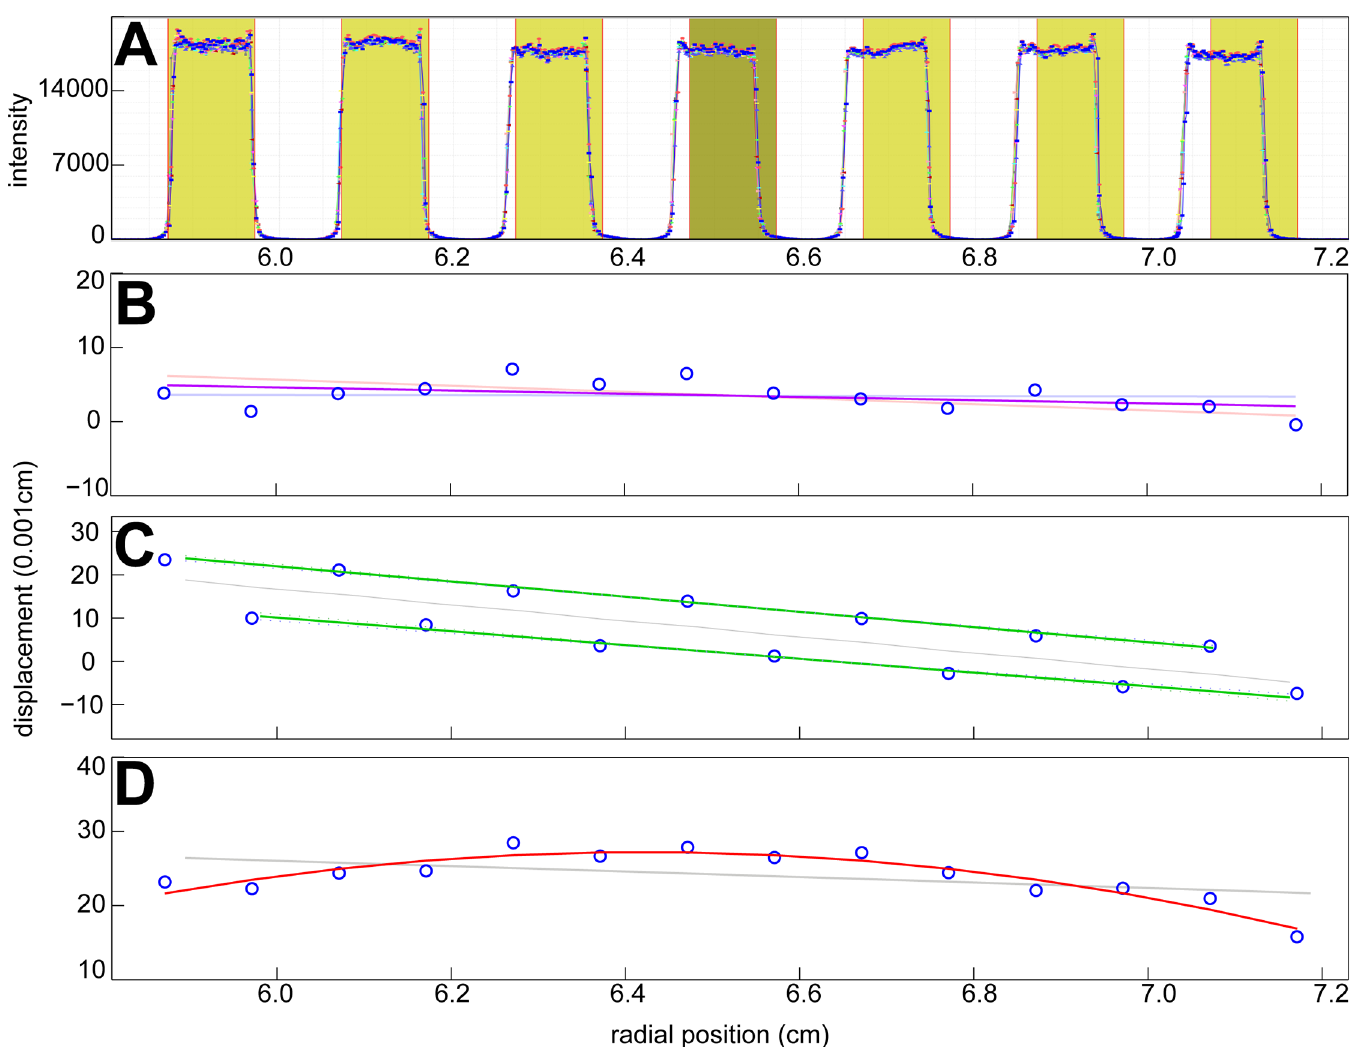
Fig 2. Examples for the determination of radial magnification errors. (A) Radial intensity profile measured in scans of the precision mask. Blue lines are experimental scans, and shaded areas indicate the regions expected to be illuminated on the basis of the known mask geometry. In this example, the increasing difference between the edges corresponds to a calculated radial magnification error of -3.1%. (B — D) Examples for differences between the experimentally measured positions of the light/dark transitions (blue circles, arbitrarily aligned for absolute mask position) and the known edge distances of the mask. The solid lines indicate the linear or polynomial fit. (B) Approximately linear magnification error with a slope corresponding to an error of -0.04%. Also indicated as thin lines are the confidence intervals of the linear regression. (C) A bimodal shift pattern of left and right edges, likely resulting from out-of- focus location of the mask, with radial magnification error of -1.7%. (D) A non-linear distortion leading to a radial magnification error of -0.53% in the s -values from the analysis of back-transformed data. The thin grey lines in C and D indicate the best linear fit through all data